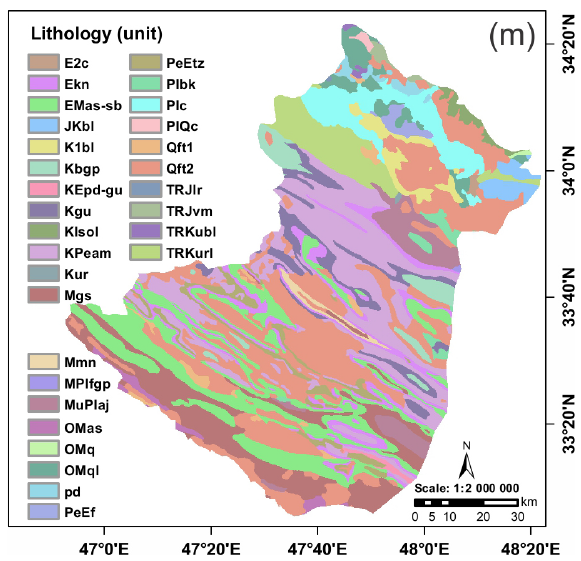
Figure 3. Groundwater conditioning factors for the study area used in this research: (a) slope degree, (b) slope aspect, (c) altitude, (d) plan curvature, (e) SPI, (f) TWI, (g) TRI, (h) distance from fault, (i) distance from river, (j) land use/land cover, (k) rainfall, (l) soil order, and (m) lithology